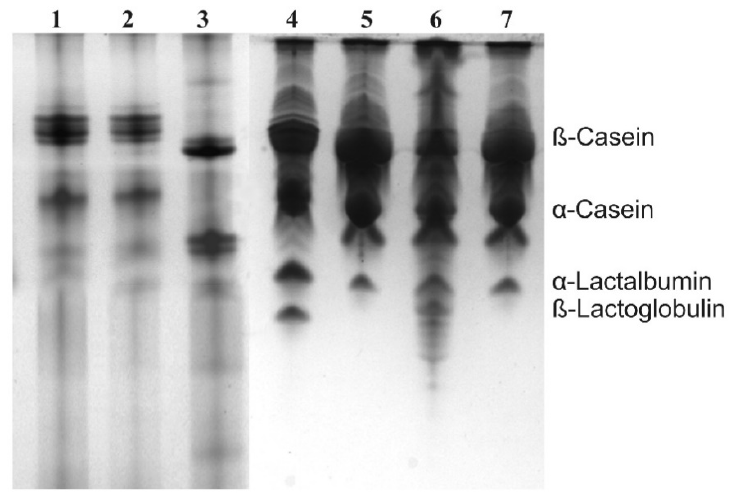
Figure 1. Electrophoretograms of milk from impala (lanes 1 and 2), cow (lane 3), sheep (lane 4), and tsessebe (lanes 5–7).